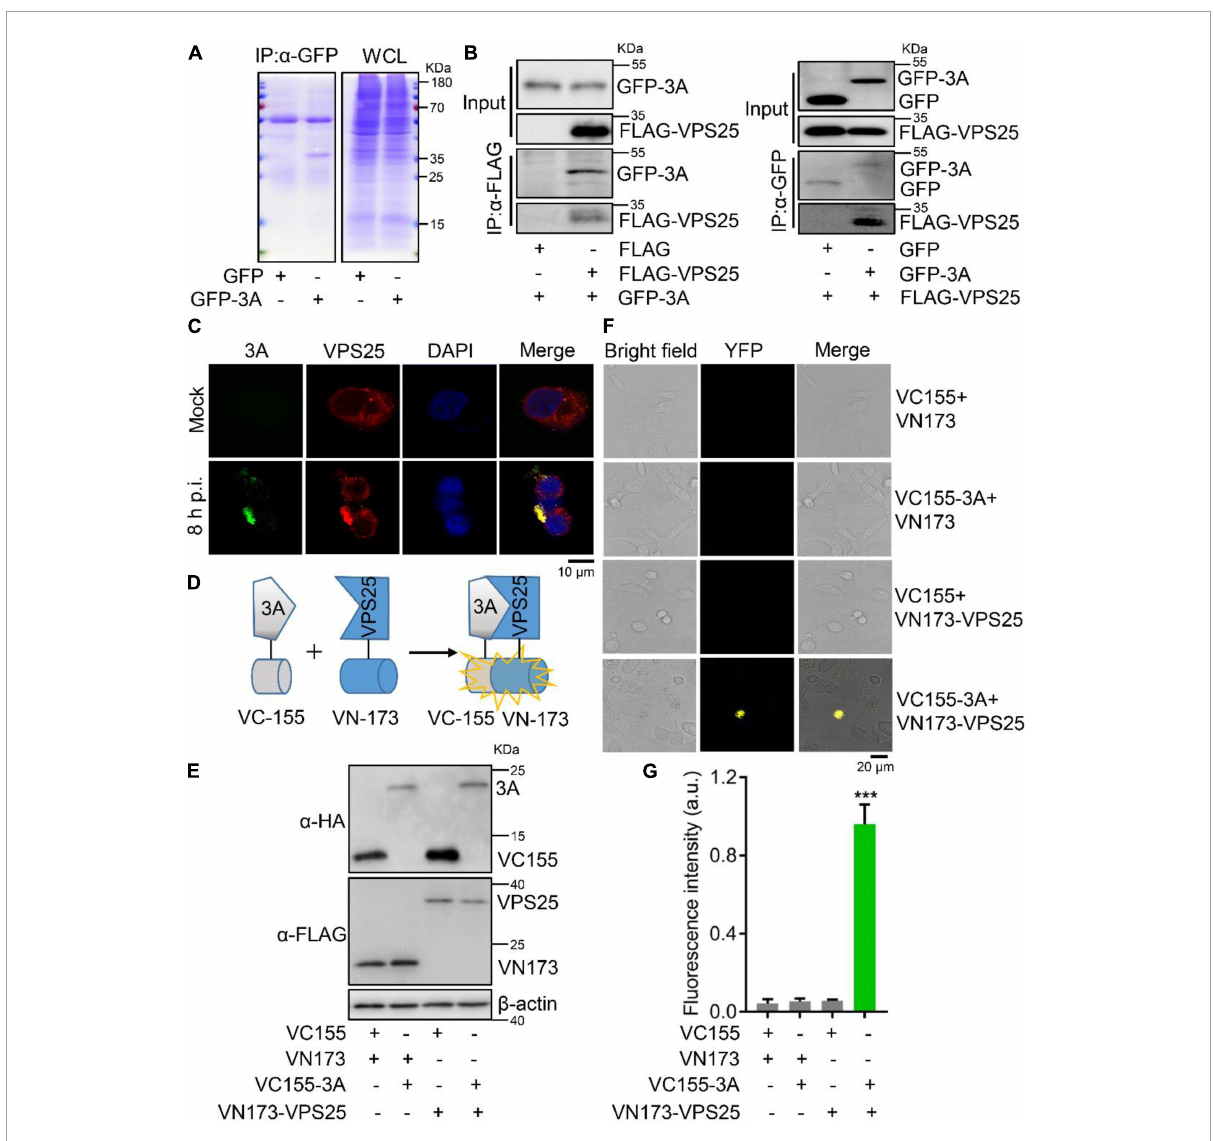
FIGURE3 Enterovirus 71 (EV71) 3A protein interacts with VPS25. (A) RD cells were transfected with plasmids expressing GFP or GFP-tagged 3A. Cell lysates were immunoprecipitated with anti-GFP ( α -GFP) antibody. The protein samples were separated by SDS-PAGE and visualized with Coomassie blue staining. (B) HEK293T cells were co-transfected with empty or indicated plasmids expressing FLAG-tagged VPS25 or GFP-tagged 3A, followed by the immunoprecipitated with anti-FLAG ( α -FLAG) or anti-GFP ( α -GFP) antibody, respectively. The corresponding proteins were detected by Western blot analysis. (C) RD cells were infected with EV71 (MOI = 0.5) for 8 h. Immunofluorescence assay was performed after labeling proteins of EV71 3A (green), VPS25 (red), and staining nuclei with DAPI (blue). (D) Schematic of bimolecular fluorescence complementation assay (BiFc). (E–G) RD cells were co-transfected with Venus BiFc plasmids expressing control protein (VC155 or VN173), 3A protein (VC155-3A), and VPS25 protein (VN173-VPS25), respectively. At 24 h post-transfection, the expression of corresponding proteins was detected by Western blot analysis (E) or visualized by confocal microscopy (F) . The fluorescence intensity was analyzed using ImageJ software (G) . YFP, yellow fluorescence protein; a.u., arbitrary unit. Graph shows as mean ± SD. *** P < 0.001.